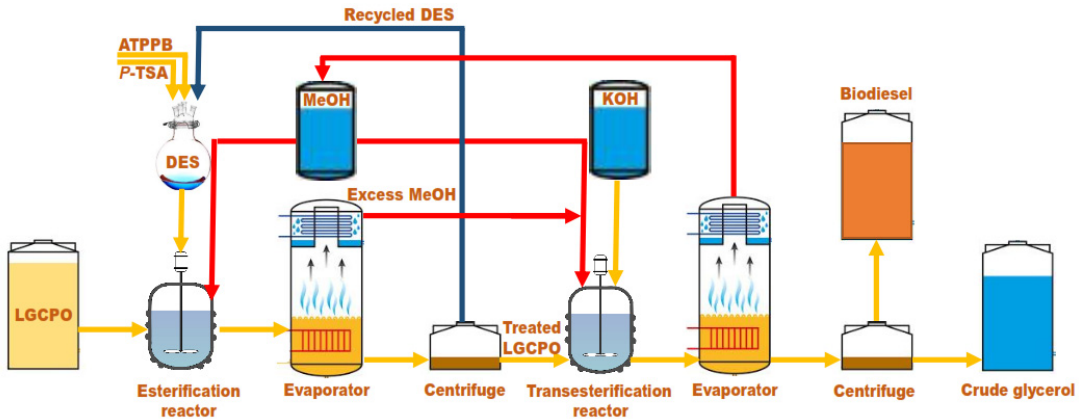
Figure 6. The flowchart to obtain glycerol and biodiesel from low-grade crude palm oil (LGCPO).